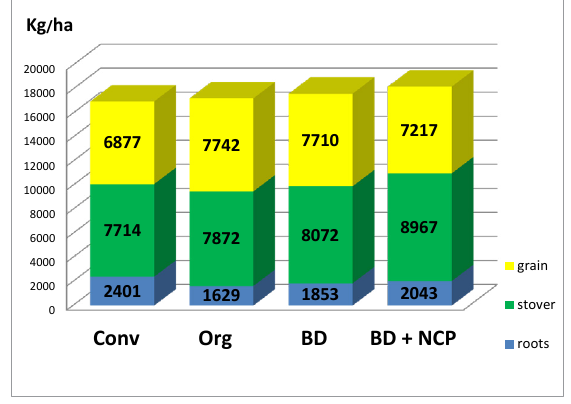
Figure 5: Partitioning of biological yield in 1998